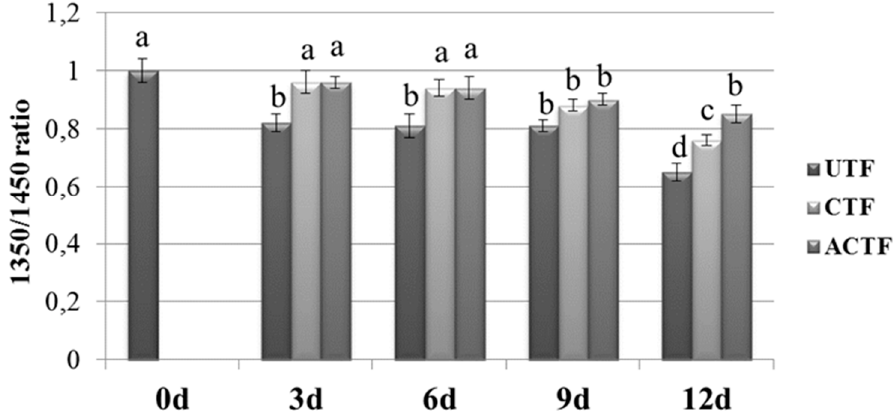
Figure 10. Diagram of the ratio between amide III peak (1305 cm − 1 ) and the pyrrolidine peak (1451 cm − 1 ) of uncoated (UTF), coated (CTF), and coated with ELO (ACTF) trout fillets, after 12 days of storage at 4 ◦ C. Results are representative of three trout analyzed for each experimental group. Different letters on the columns indicate statistically different values ( p < 0.05); d =